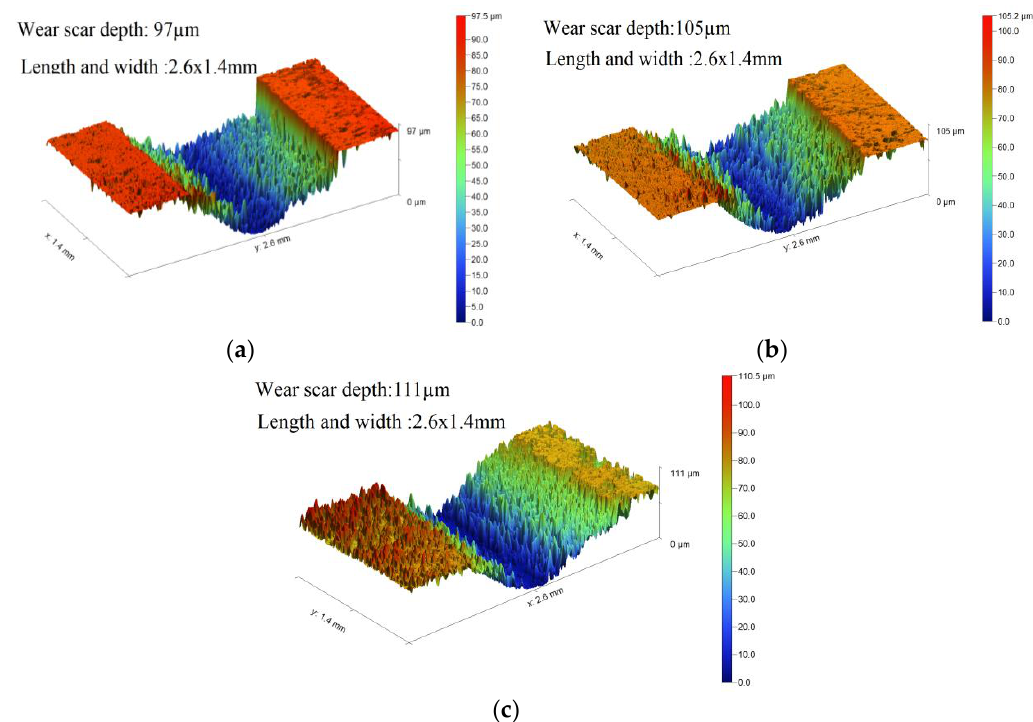
Figure 9. 3D morphology of the wear marks under different forces, magnified 10×: ( a ) 20 N; ( b ) 25 N; ( c ) 30 N.